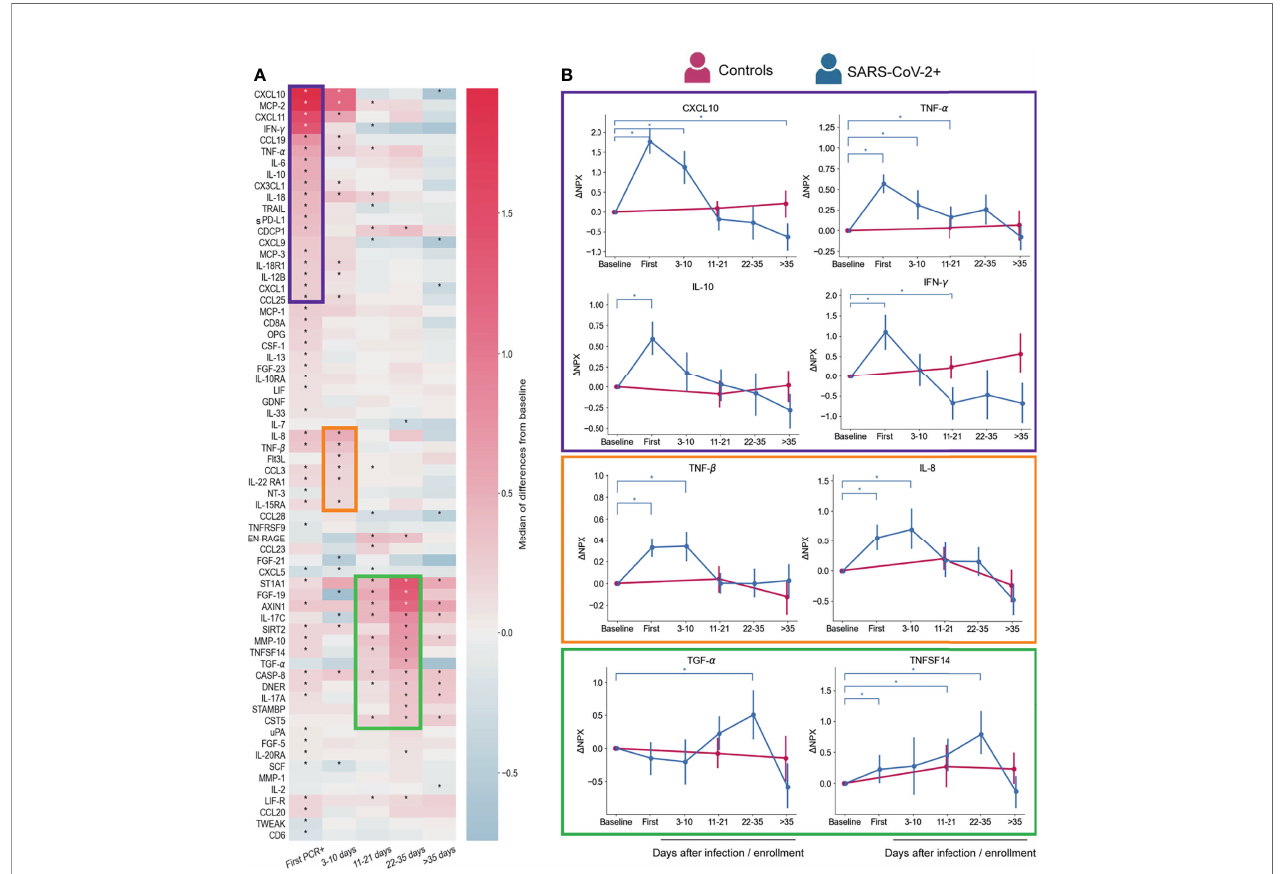
FIGURE 2 | Serum proteins measured by PEA with overall changes over time with respect to pre-infection (n=88 participants) regardless symptoms status. (A) Heatmap showing the proteomic signature with relative expression of the markers with signi fi cant changes overtime in infected participants. (B) Representative temporal pro fi le of markers belonging to the fi rst, second and third wave (represented by the boxes in purple, orange and green, respectively). Controls in panel B are uninfected participants (n=23) that were included in the analysis with samples collected at study enrollment (baseline), 14 days, and 56 days after enrollment. Mean and 95% CI are indicated. *p <